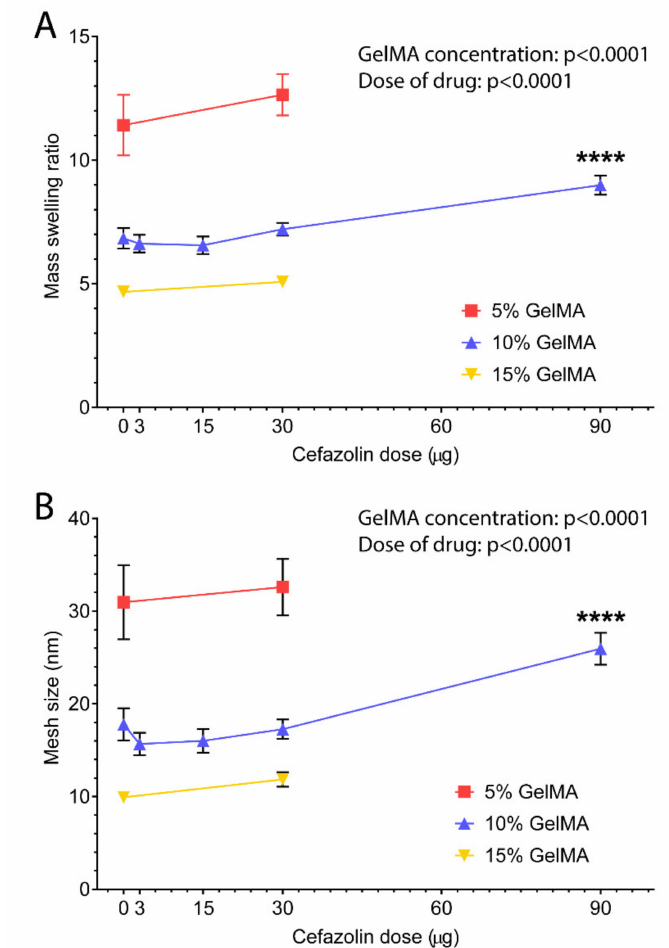
Figure 4. Equilibrium swelling ratio and mesh size of GelMA. GelMA-DDS hydrogels at 5%, 10%, and 15% GelMA for cefazolin doses of 3 µ g, 15 µ g, 30 µ g, and 90 µ g. ( A ) Equilibrium swelling ratio after 7 days of swelling in phosphate-saline buffer at 37 ◦ C. ( B ) Mesh size in nm. The experiment was performed once with n = 5–7. **** p <